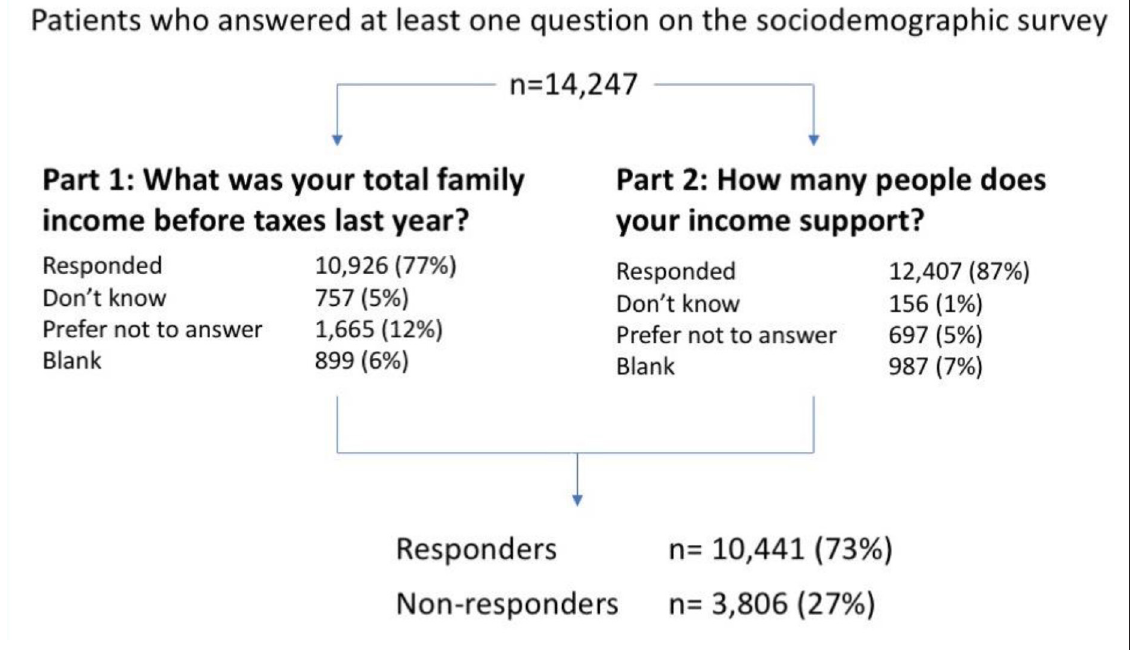
Figure 2 Responses to income questions. Responders are those who responded to both parts of the question. Non- responders answered ‘don’t know’, ‘prefer not to answer’, or left a question